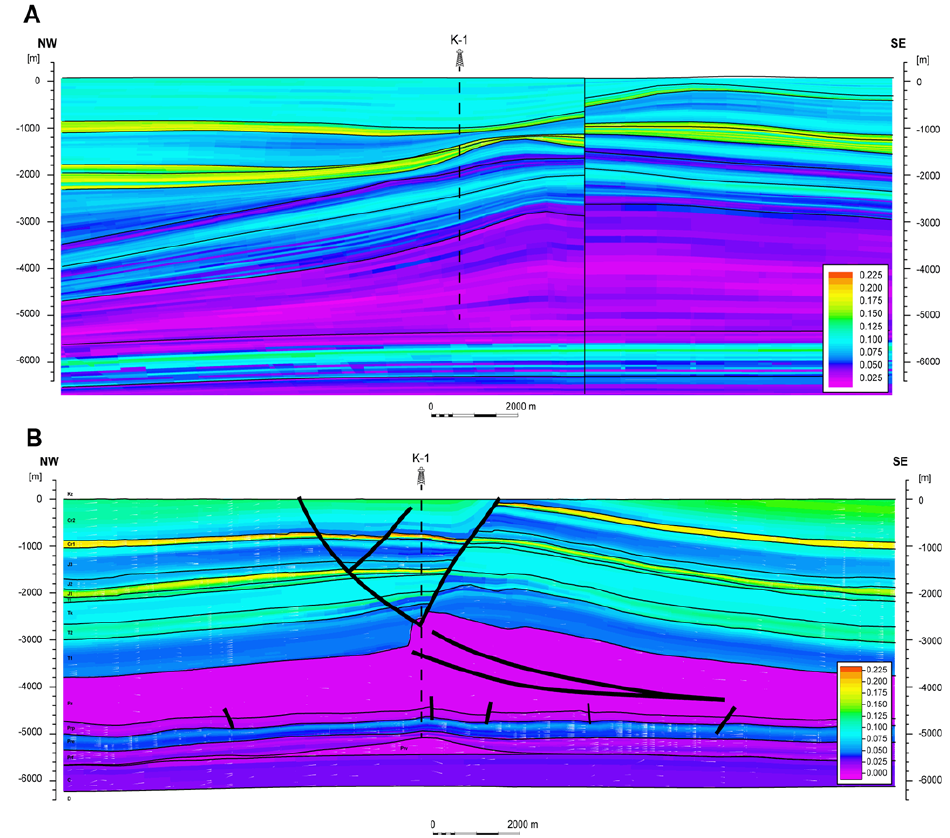
Figure 14. Distribution of the porosity (PHI) along the NW–SE cross-sections: ( A ) upper part, SMV1; ( B ) lower part, SMV2.